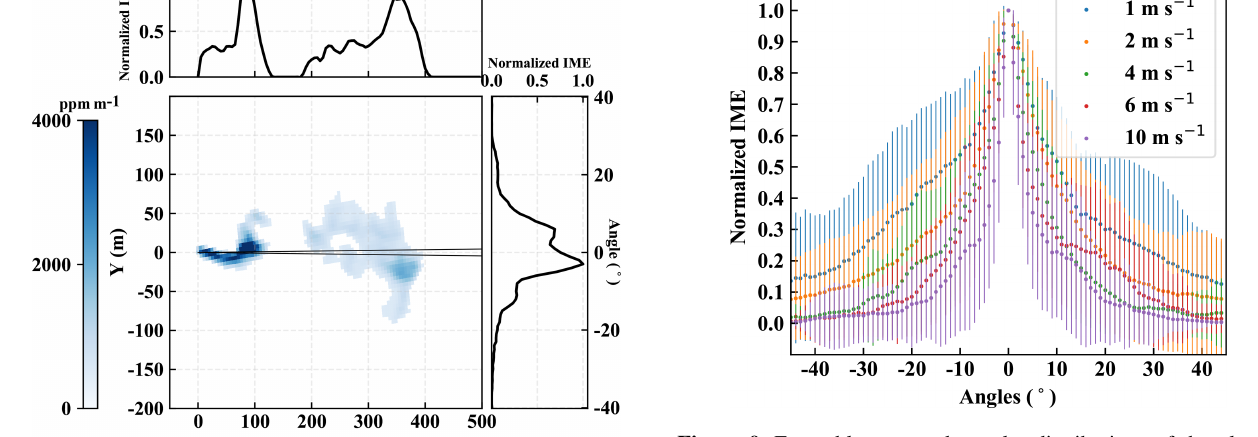
Figure 9. Ensemble-averaged angular distributions of the plume, averaging over all available time steps at various flux rates. Differ- ent colors represent different wind speeds. Each distribution is nor- malized by its maximum value. The vertical bars represent 1 stan- dard deviation of the normalized IME at a given angle across all